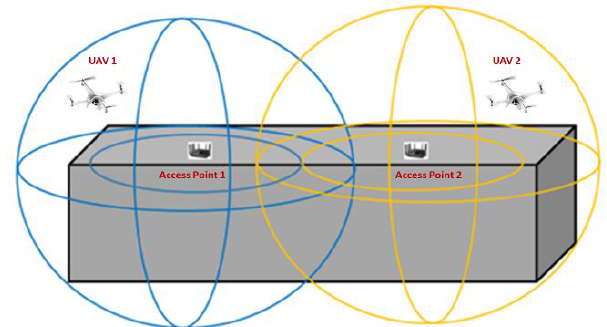
Figure 6 . The coverage of the wireless LAN network Figure 6 shows the coverage of the wireless LAN network where the UAVs are equipped with the ESP8266 module to locate the position while